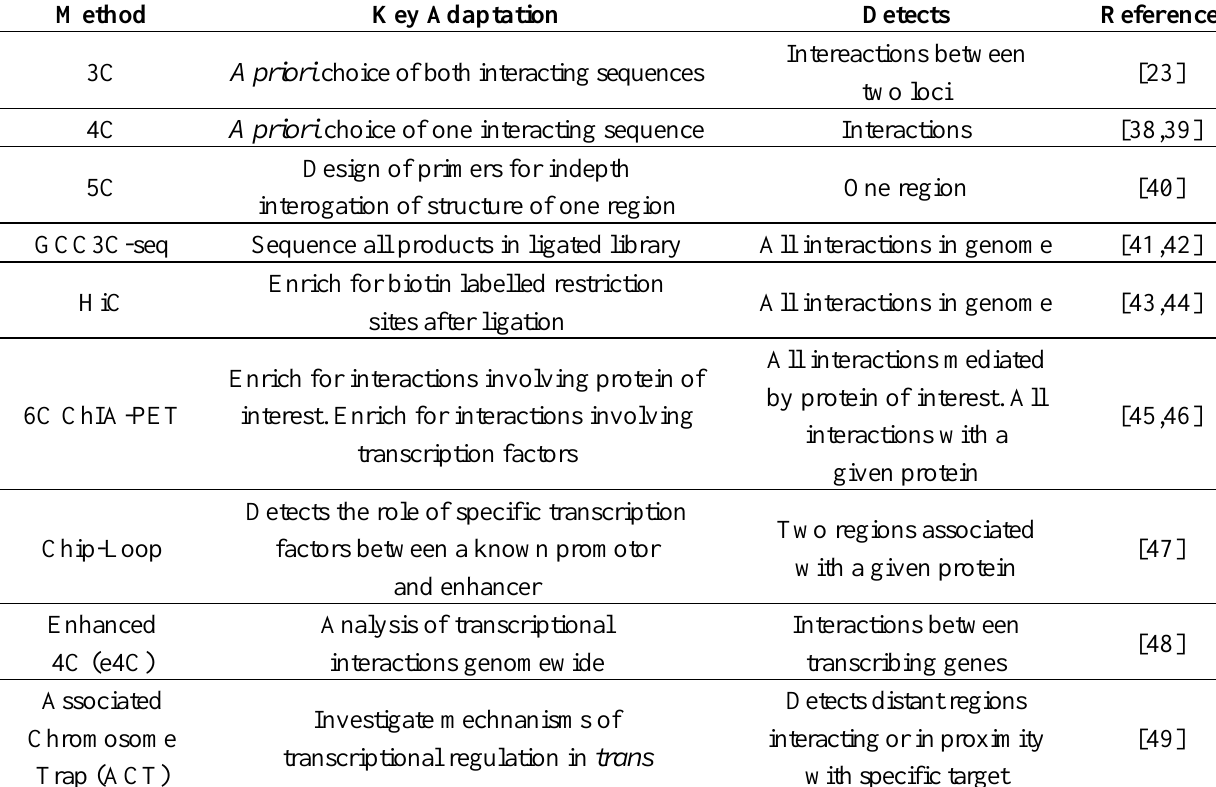
Table 2. The basic suite of proximity ligation methods used for the interrogation of chromosome structure. Modified from